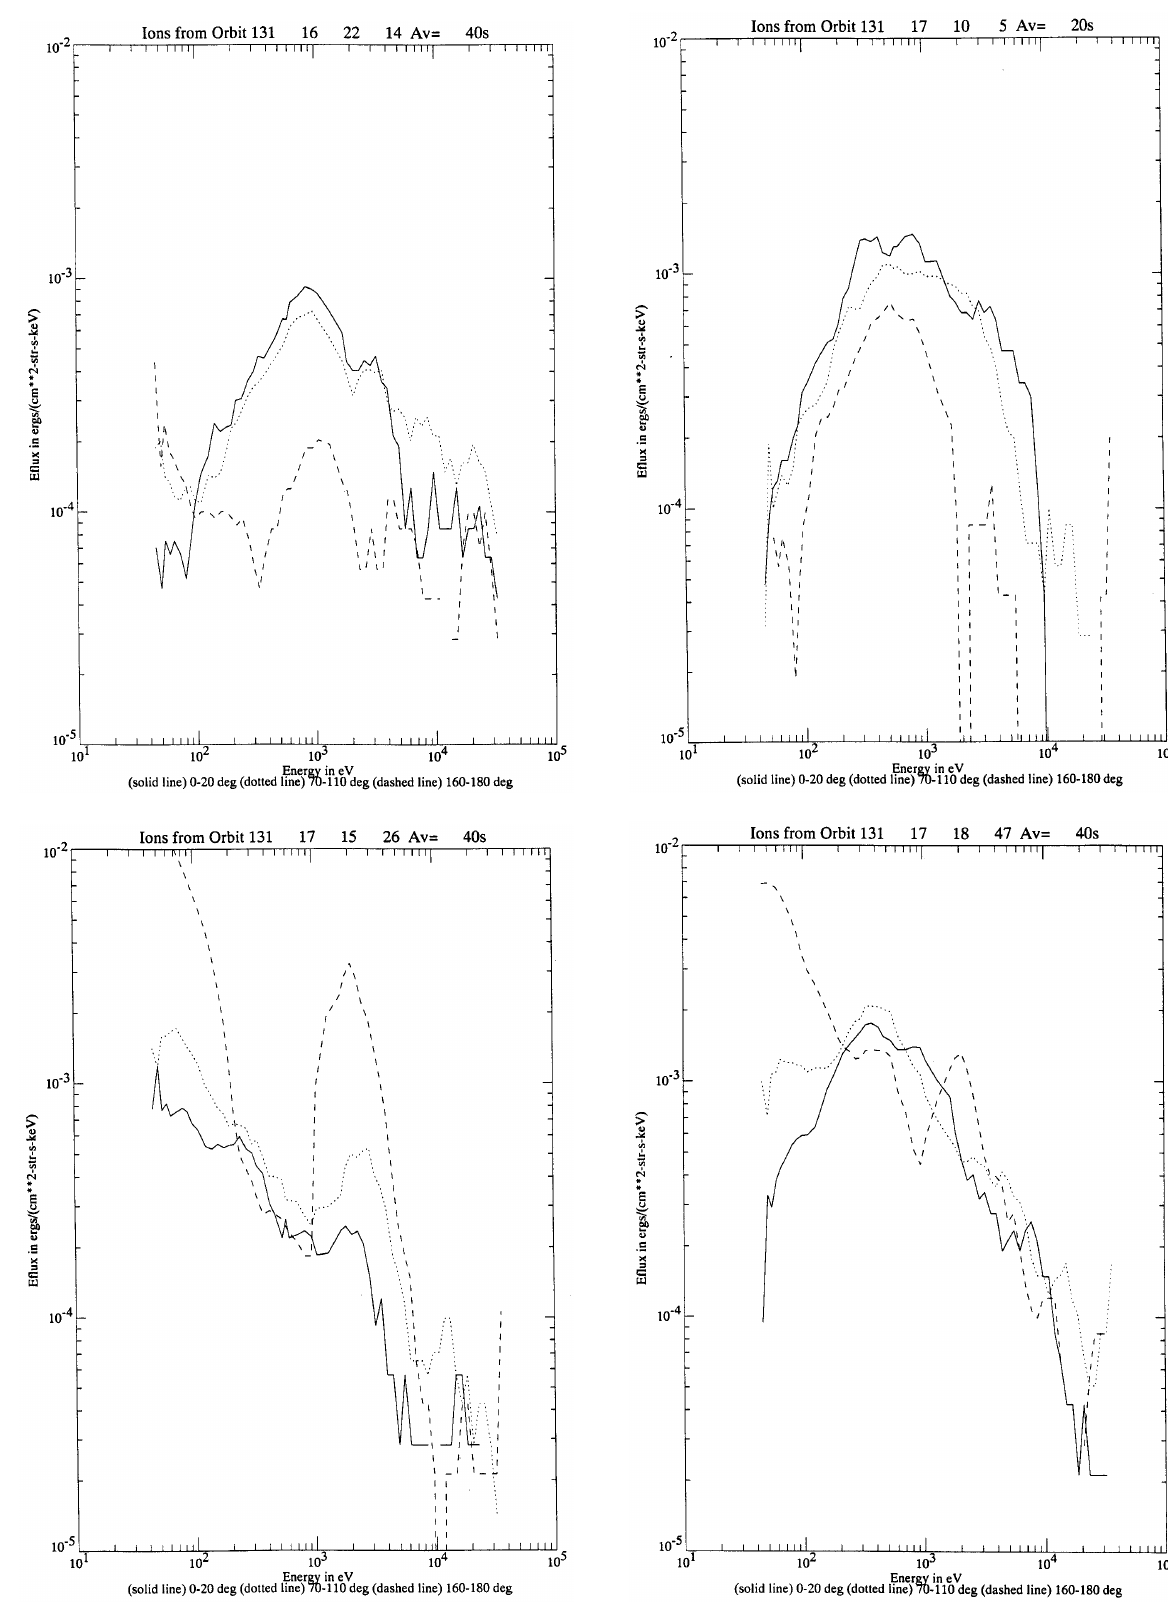
Fig. 6b. Ion spectra for different pitch-angles observed at mid-altitude by Viking on the pass shown in Fig. 5. The spectra were measured close to 0 ◦ , 90 ◦ and 180 ◦